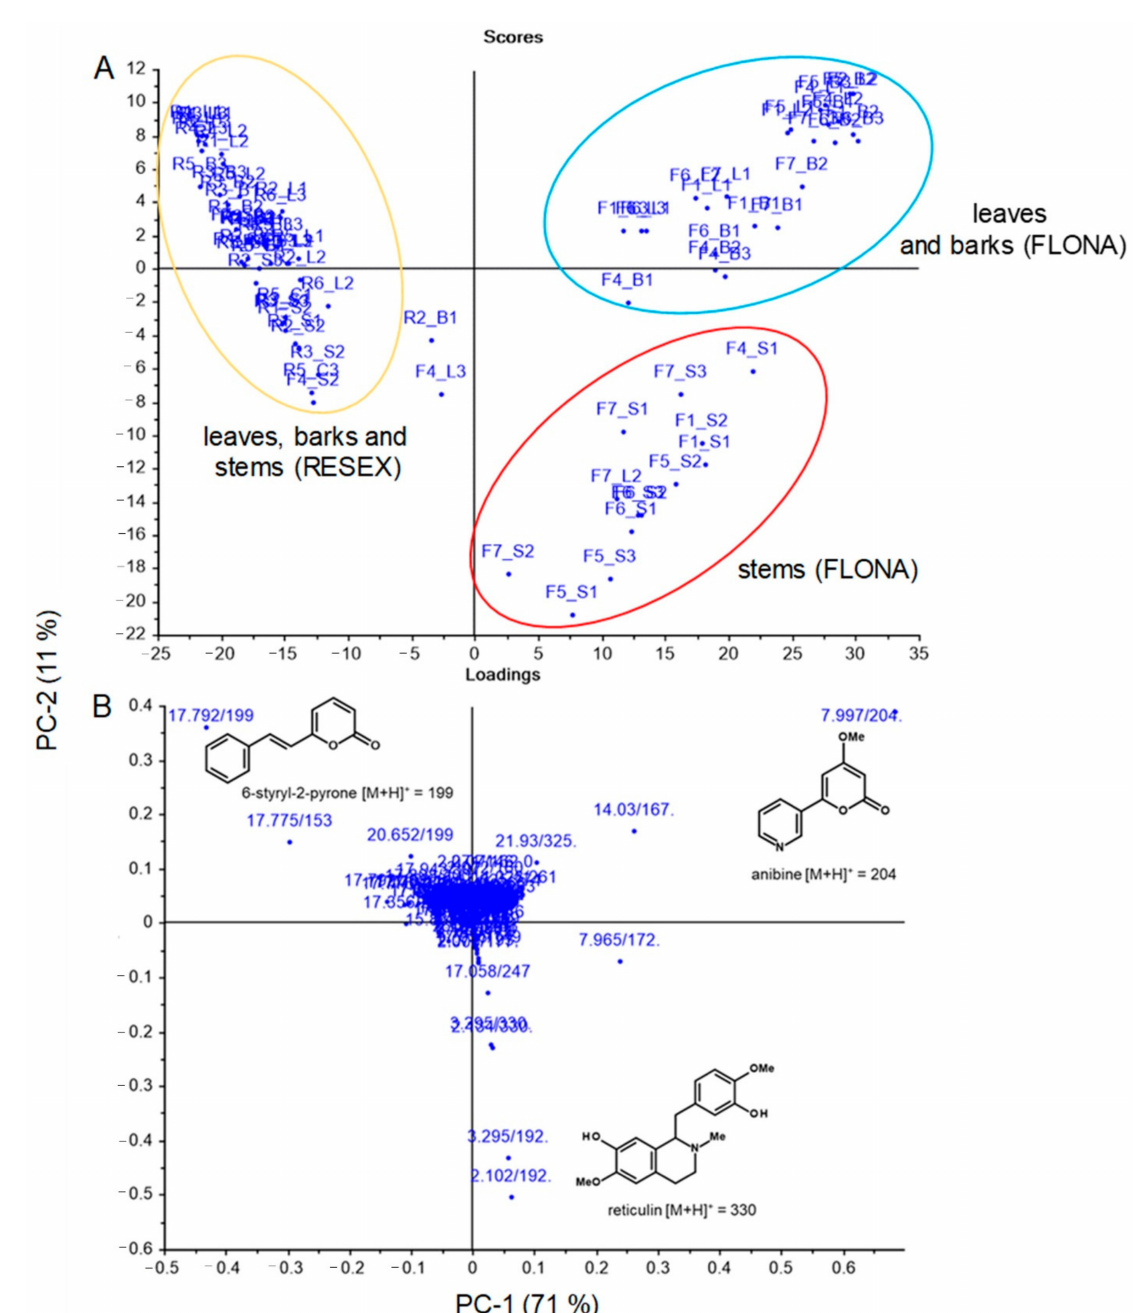
Figure 1. Results of a principal component analysis (PCA) from ESIHRMS data, illustrating the relationship between samples of A. rosiodora from FLONA and RESEX reserves. ( A ) The score plot and ( B ) the PCA derived loading plot, presenting the contribution of RT/( m / z ) data with cumulative 82% variance within the two components (PC1 and PC2). Samples are coded by “locality_tissue type”, with R = RESEX, F = FLONA, B = bark, S = stems, and L =